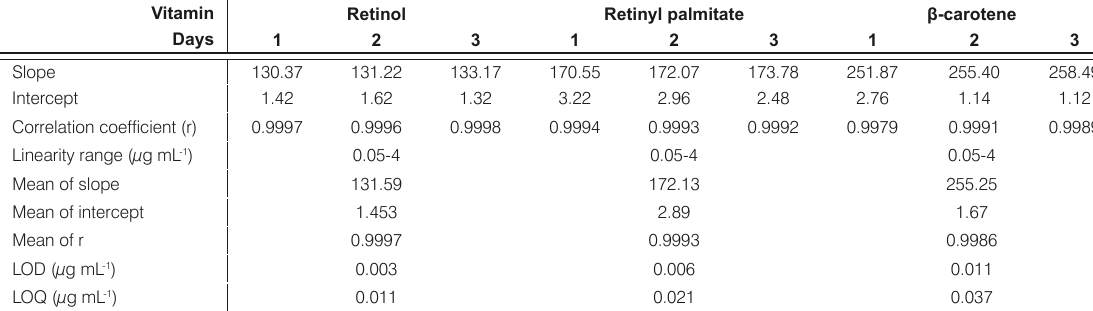
Table 2. Statistical data for the calibration graphs of Retinol, Retinyl palmitate and β -Carotene standards in mobile phase Vitamin Retinol Retinyl palmitate Days